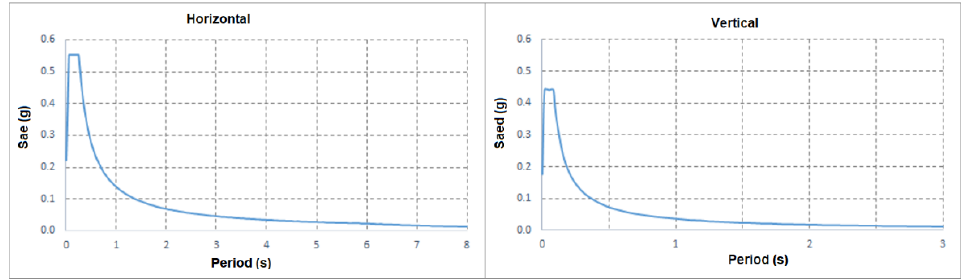
Figure 3. Horizontal/vertical elastic design spectrum used for the structural analysis.